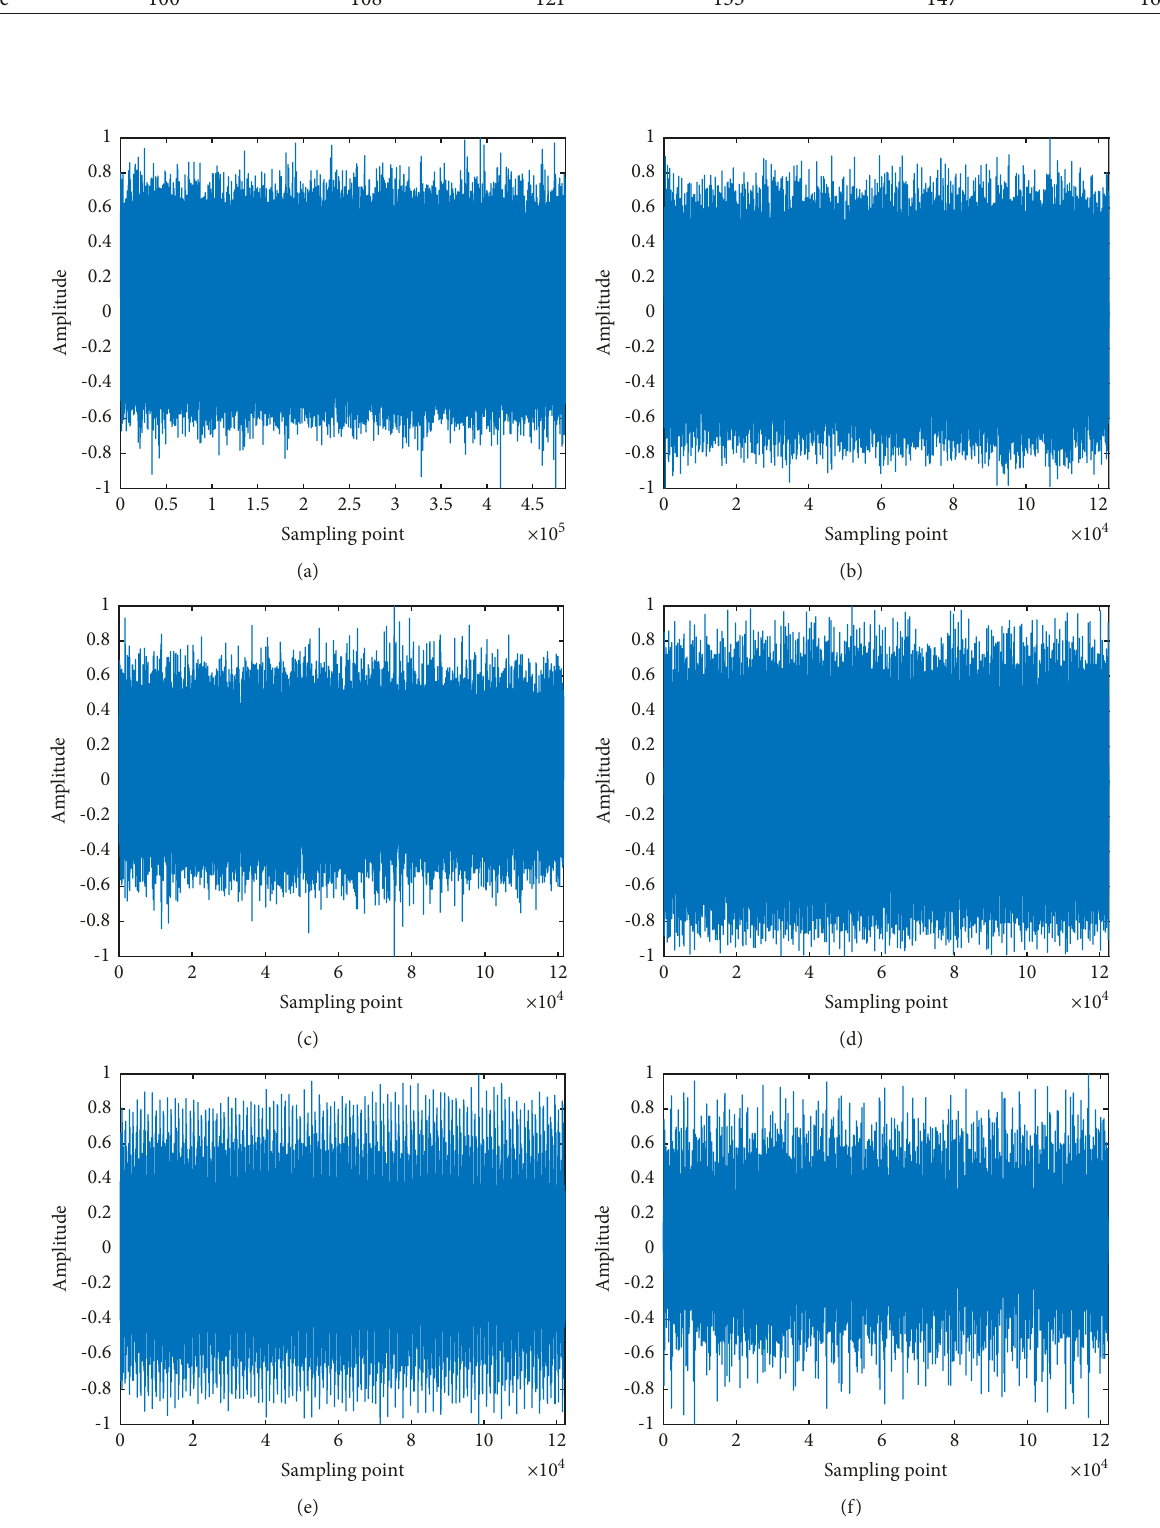
Figure 3: The normalized six types of bearing signals. (a) 100, (b) 108, (c) 121, (d) 133, (e) 147, (f) 160.